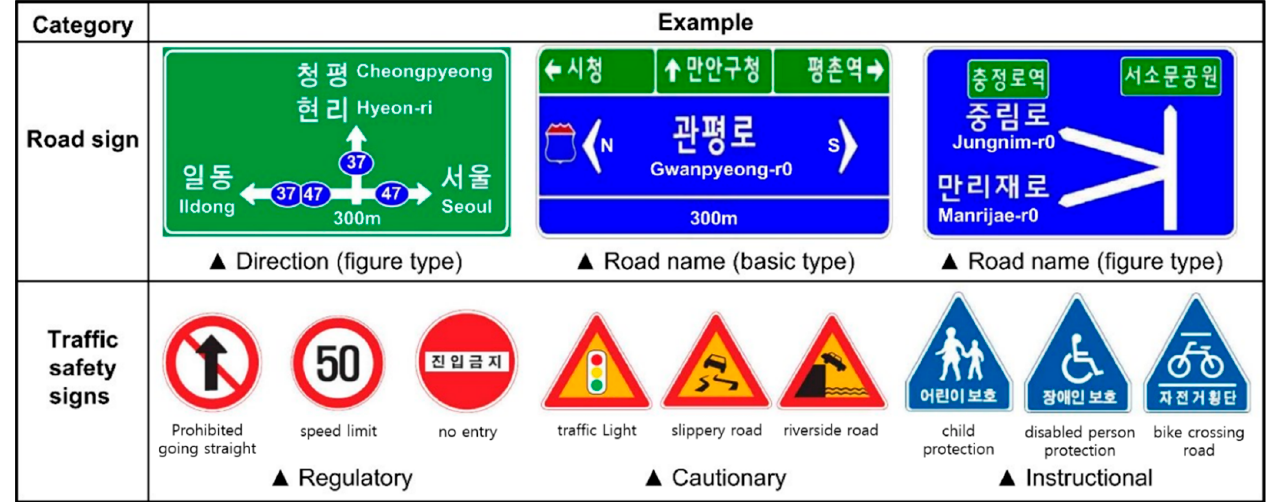
Figure 1. Categories of South Korean road signs.